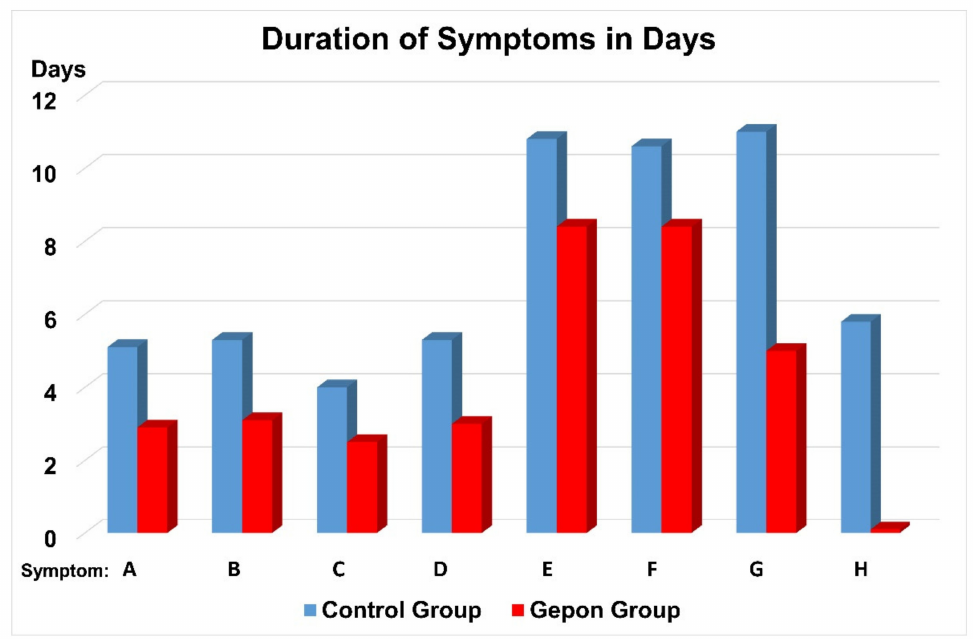
Figure 3. Duration of symptoms in days in patients with acute viral respiratory infection and pneumonia. Symptoms: A—fever, B—intoxication, C—headache, D—weakness, E—inflamed tonsils, F—mucosal hyperaemia, G—swollen lymphnode and H—purulent stomatitis. Control Group